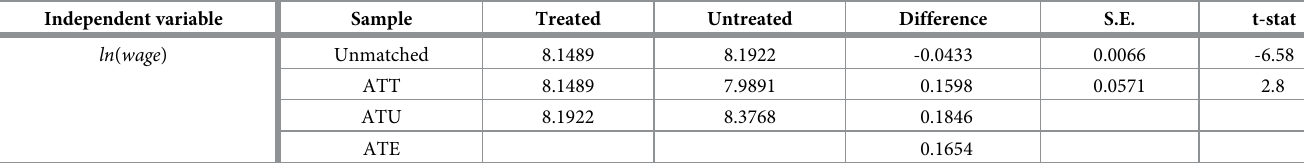
Table 3. The results of one-to-one nearest neighbor matching (with replacement).